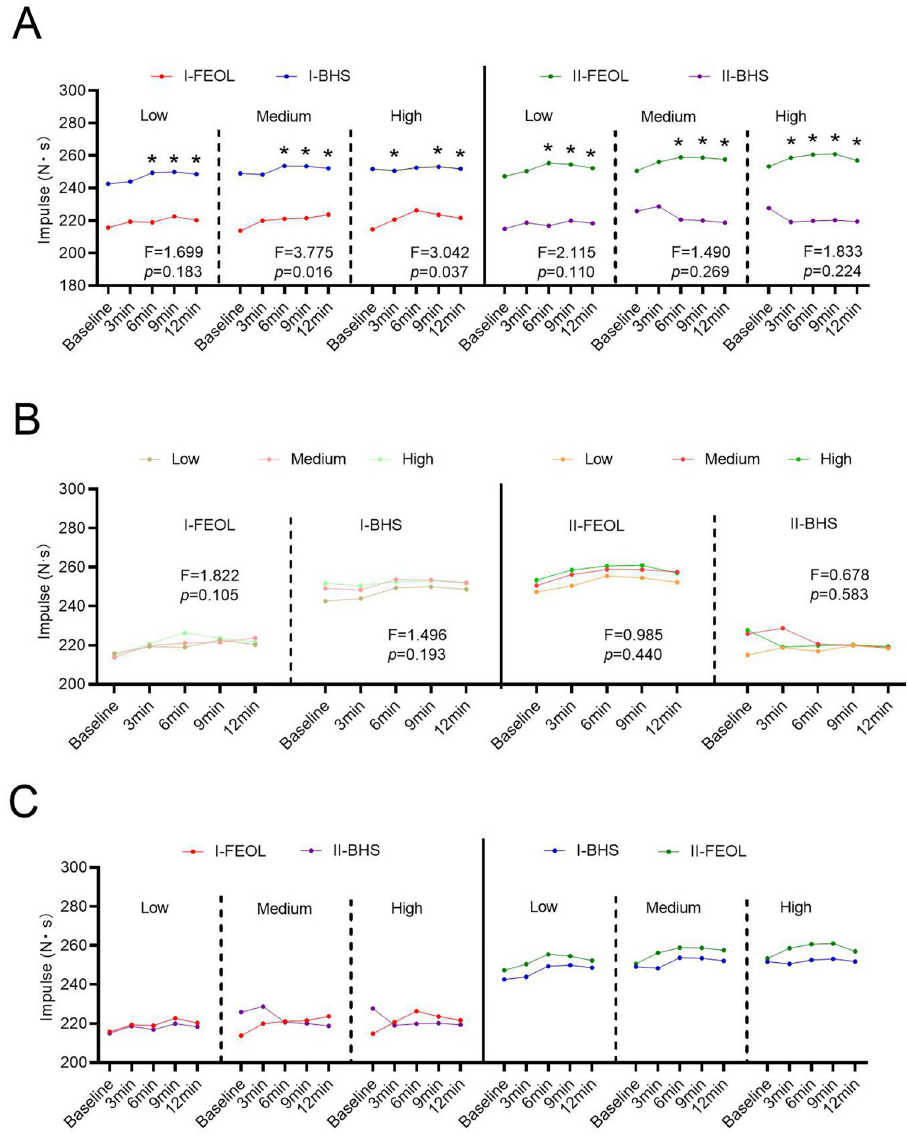
Fig 4. Effects of training intensity, interval time, and training method on jump impulse in two stages. (A) Time × protocol interaction effects on impulse over time in different training intensities. (B) Time × training intensity interaction effects on impulse over time in different training methods. (C) Comparison of impulses of the same crowd under different training methods in the two stages.